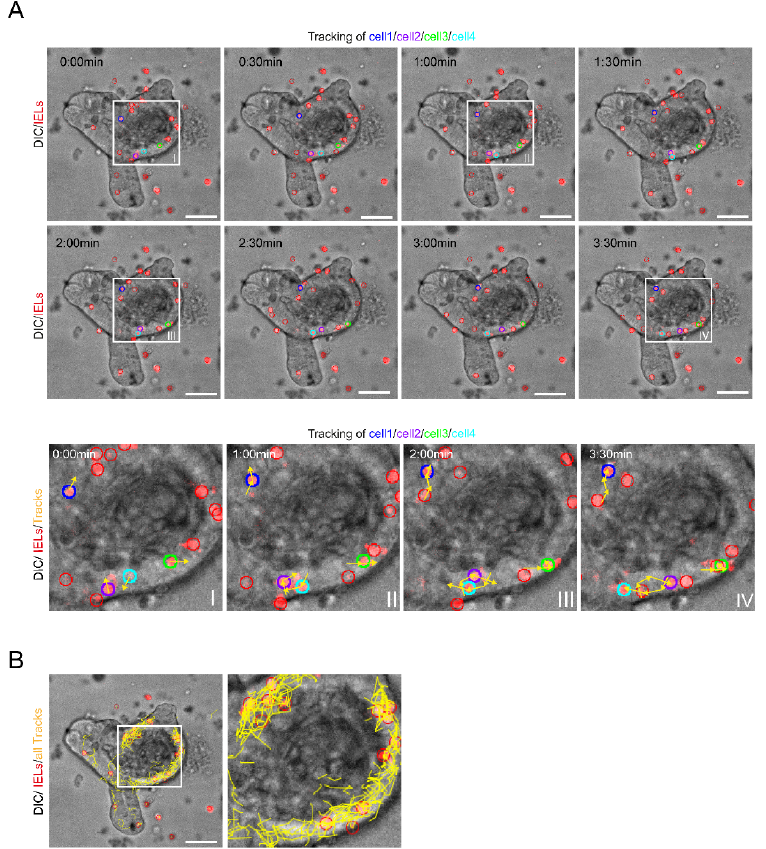
Figure 3. The mobility of IELs within the IEC layer can be monitored by life cell imaging and tracked with time-lapse studies. ( A ) IEL-IEC co-cultures with pre-stained IELs (Cell Proliferation Dye, red) were serially monitored by time-lapse imaging using spinning disc microscopy with 25 × objective magnification in DIC. Time series demonstrates eight frames with each frame taken 30 sec apart. Four exemplary IELs are marked in blue, purple, green, and turquoise, respectively. The movements of the four exemplary IELs within the epithelium during the observation period are highlighted by yellow arrows and lines (tracks) in the close-up views (I–IV). Scale bars 50 µ m. ( B ) Tracks of all IELs detectable during the observation period of 45 min are shown by yellow lines. Scale bar 50 µ m. Co-culture was incubated overnight before imaging.